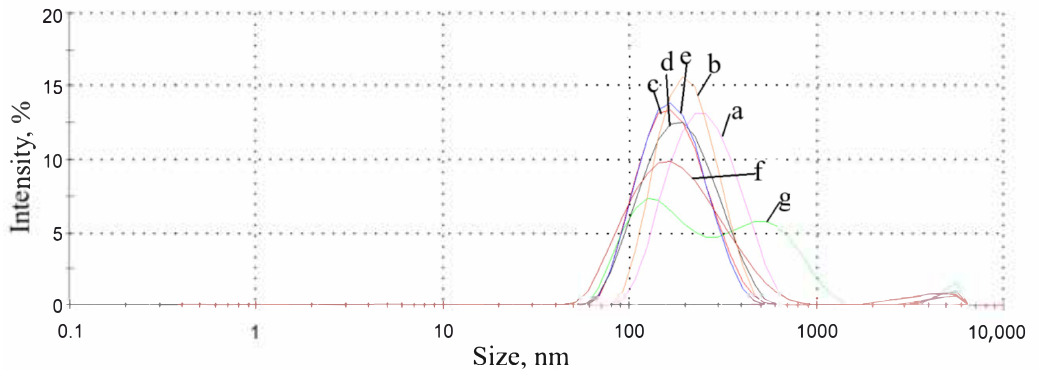
Figure 3. Size distribution by intensity of pyraclostrobin-loaded submicrocapsules (PyrSMCs) depending on octadecane (OD):TPM weight ratio in the oil phase. a—1:9; b—1:4; c—3:7; d—2:3; e—1:1;